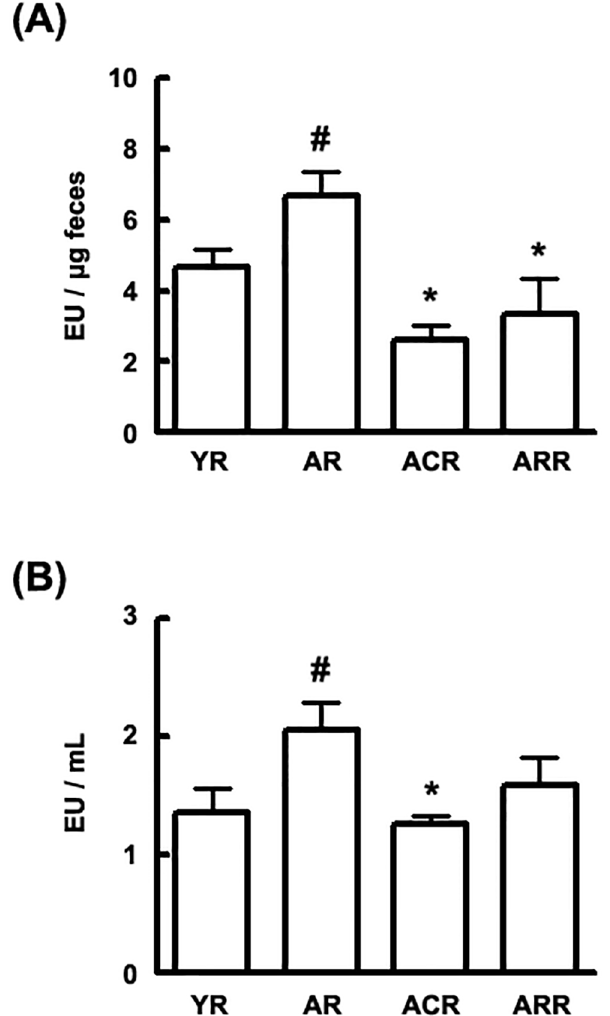
Fig 6. Effect of C29 on the fecal and plasmatic LPS concentrations in young and aged F344 rats. LAL assay was used to measure (A) the fecal and (B) plasmatic endotoxin concentrations. All values are indicated as the mean ± SD (n = 10). YR, young rats; AR, aged rats; ARC, aged rats treated with C29, ARR, aged rats treated with rapamycin (n = 10). # , p < 0.05 compared with YR; * , p < 0.05 compared with